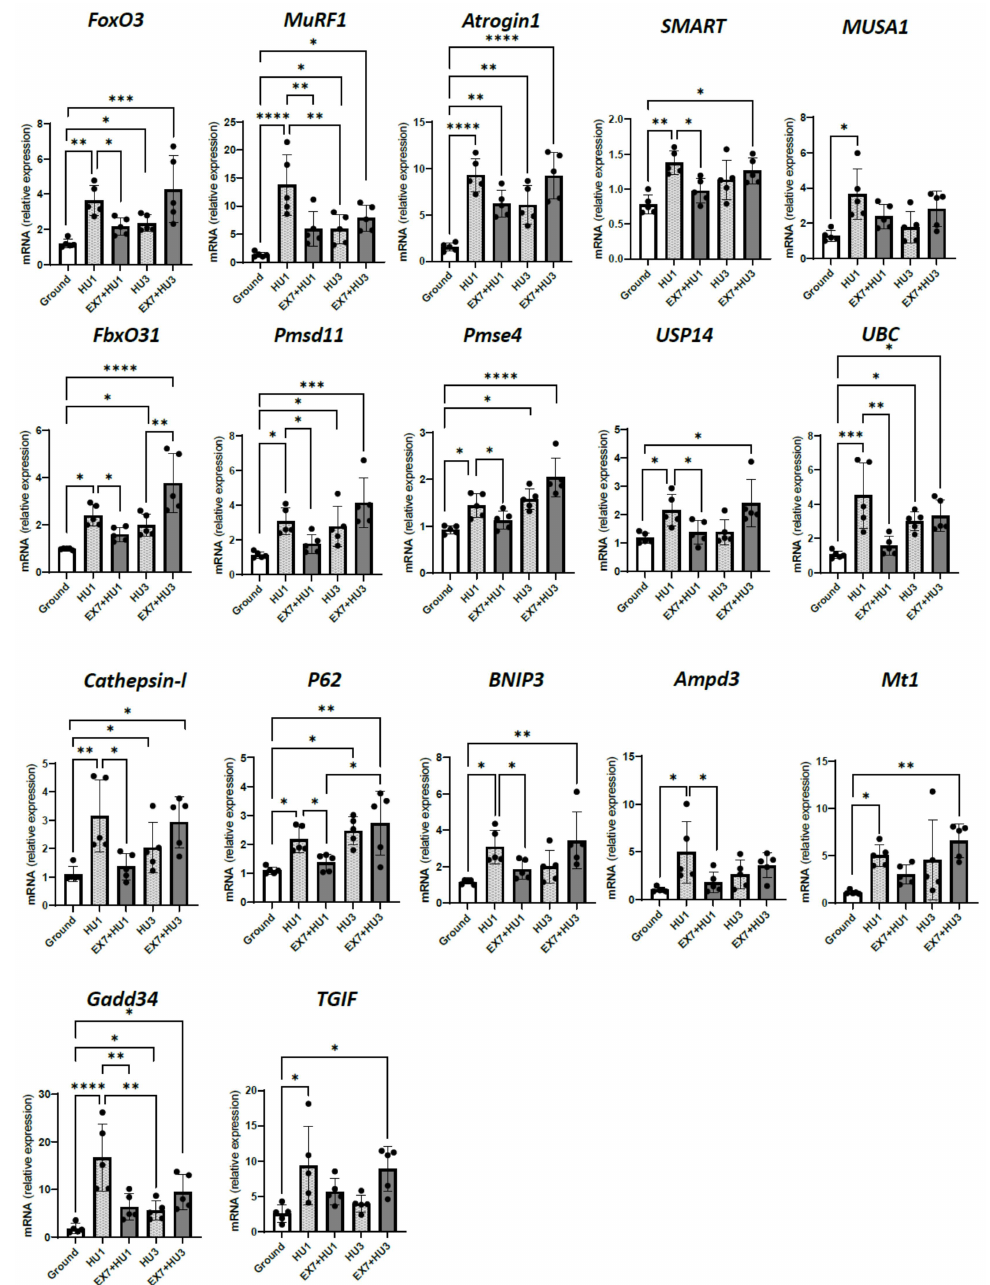
Figure 3. Physical preconditioning counteracts the early atrogenes’ induction during disuse. RT-PCR analysis of transcriptional levels of FoxO3 and the muscle-specific ubiquitin ligases MuRF1 , Atrogin1 , SMART , MUSA1 , FbxO31 , proteasome subunit atrogenes ( Psmd11, Psme4 ), de-ubiquitinating enzyme atrogene ( USP14 ), ubiquitin atrogene ( UBC ), autophagy-related atrogenes ( Cathepsin l, P62, BNIP3 ), AMP deaminase atrogene ( Ampd3 ), oxidative stress related atrogene ( Mt1 ), unfolded protein response atrogene ( Gadd34 ), transcription regulators Smad2/3 atrogene ( TGIF ). The expression levels were normalized on GAPDH . Ground: Control mice ; HU1: Mice subjected to 1 day of hindlimb unloading; EX7 + HU1: Mice subjected to 7 days of physical preconditioning followed by 1 day of hindlimb unloading; HU3: Mice subjected to 3 days of hindlimb unloading; EX7 + HU3: Mice subjected to 7 days of physical preconditioning followed by 3 days of hindlimb unloading. Data are presented as means ± SD * p < 0.05 ** p < 0.005 *** p < 0.0005 **** p <